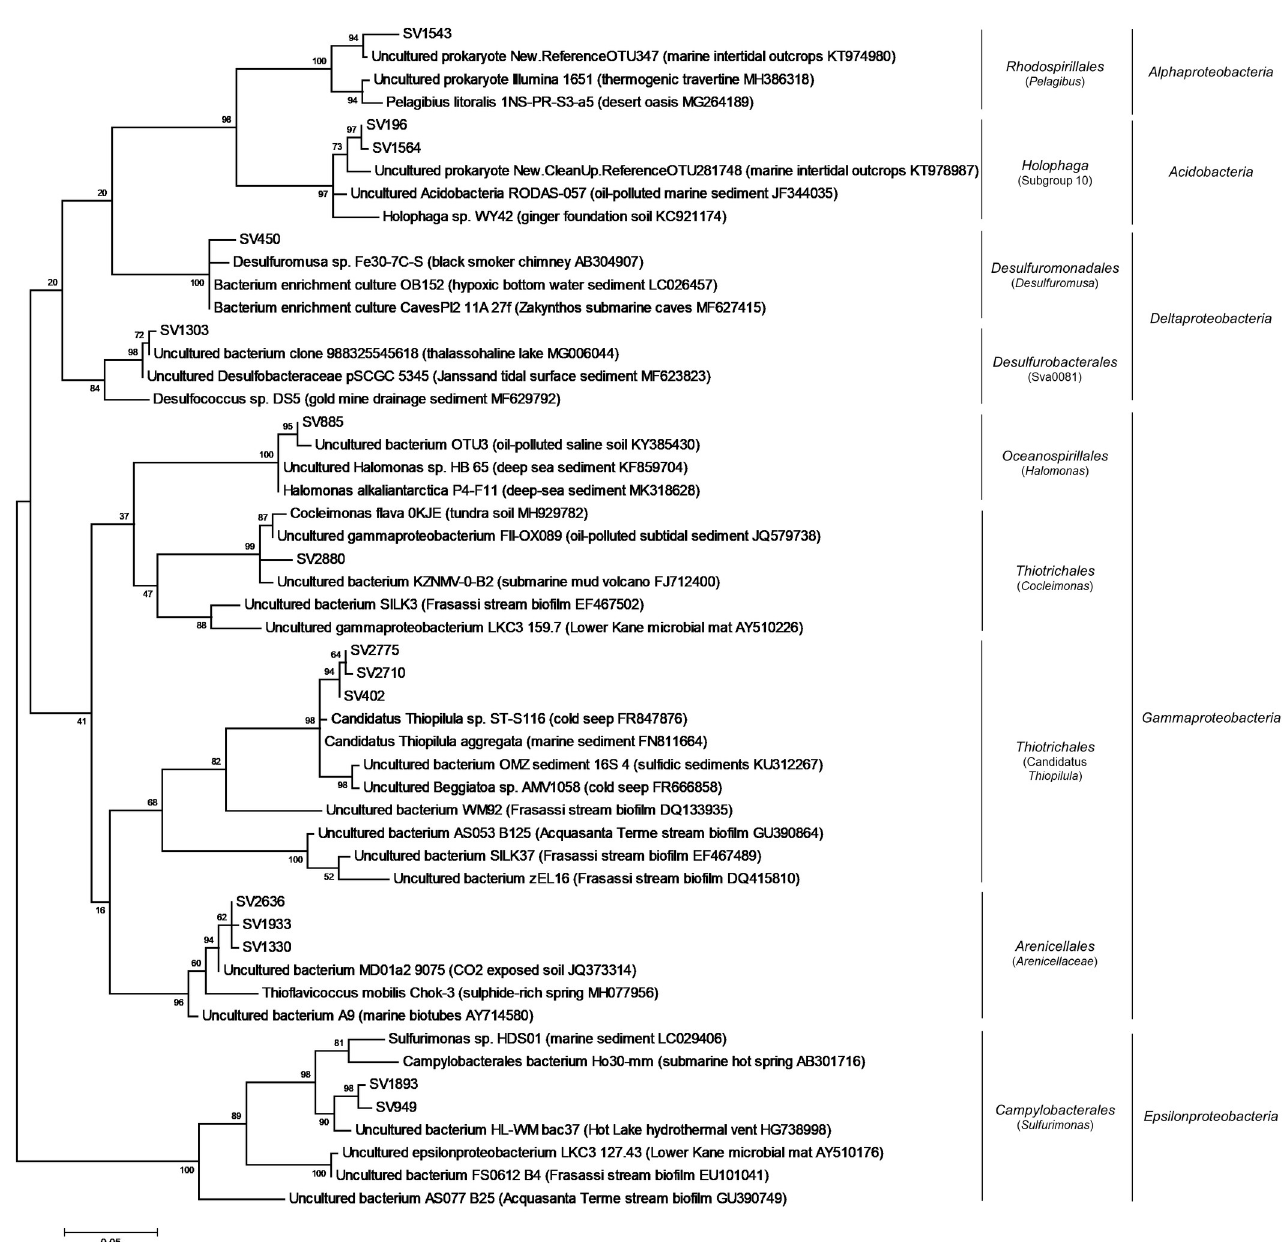
Fig 9. Phylogenetic tree of the most abundant SVs within water filaments/biofilms from Fetida Cave. For taxonomy details and Best Blast Hit of the SVs reported, see S6 Table.